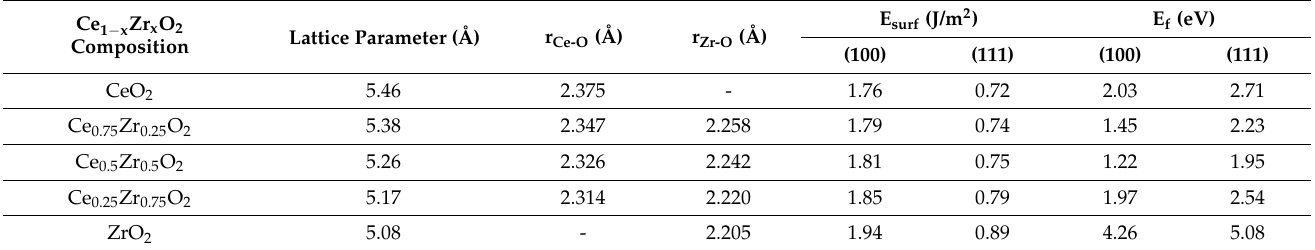
Table 1. Calculated geometric characteristics, energies of oxygen vacancy formation (E f ), and surface energies (E surf ) for Ce 1 − x Zr x O 2